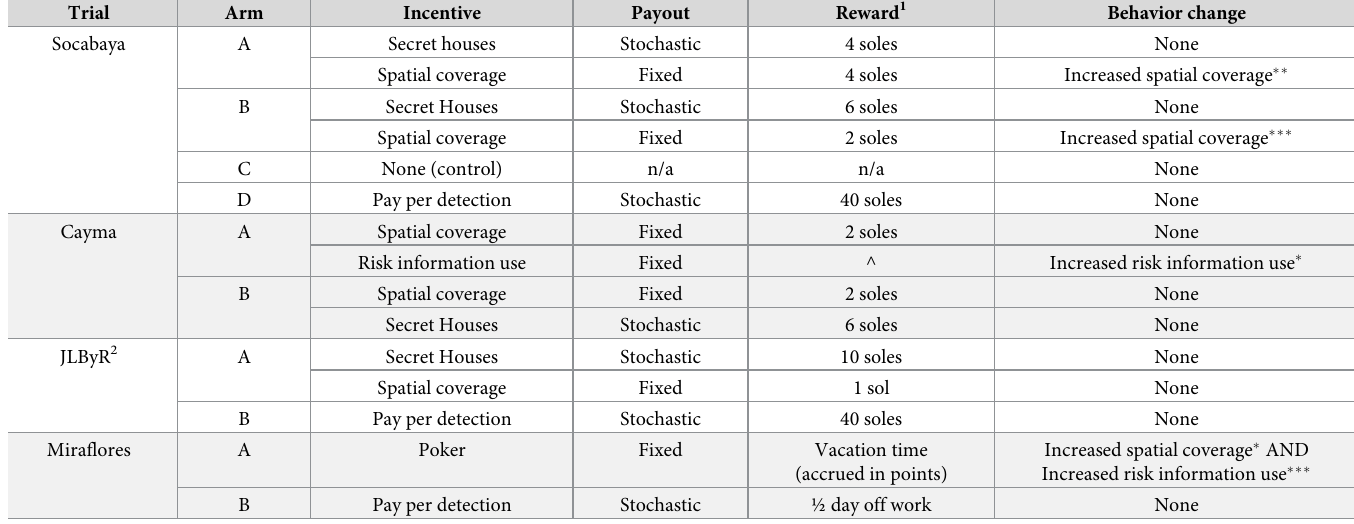
Table 2. Results